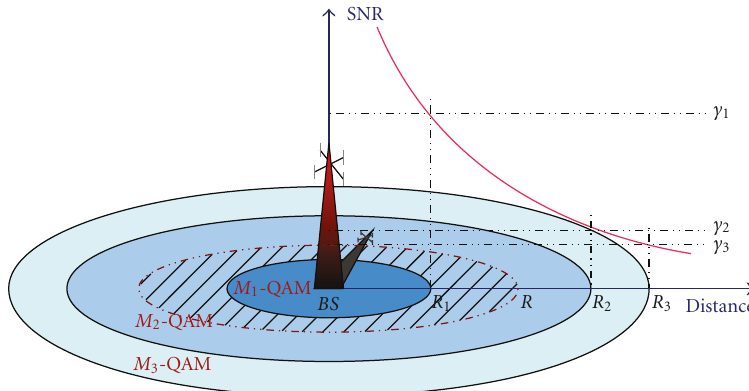
Figure 1: Modulation zones and SNR thresholds ( Q = 3 modulations).